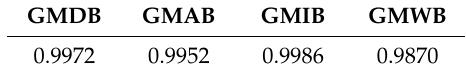
Table 2. Values of R 2 for GMxB guarantees calculated via neural networks and MC simulations.